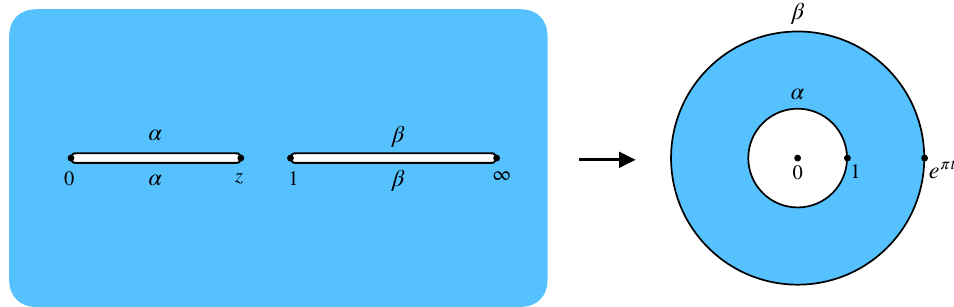
Figure 2. The complex plane with intervals [0 , z ] and [1 , ∞ ) removed is biholomorphic to the open annulus of modulus t , where z = λ ( it ) . This allows us to think of the cylinder partition function as a four-point function of twist fields in the